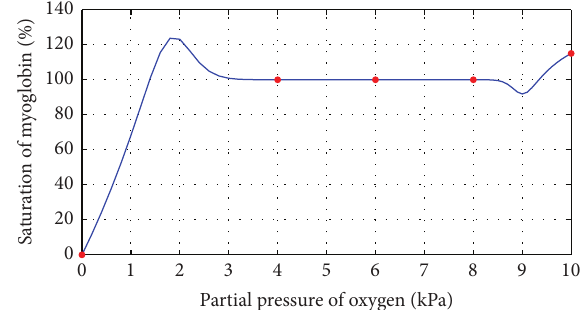
Figure 3: 𝐶 1 rational trigonometric cubic function with 𝛼 𝑖 = = 0.5, 𝛾 2.5, 𝛽 𝑖